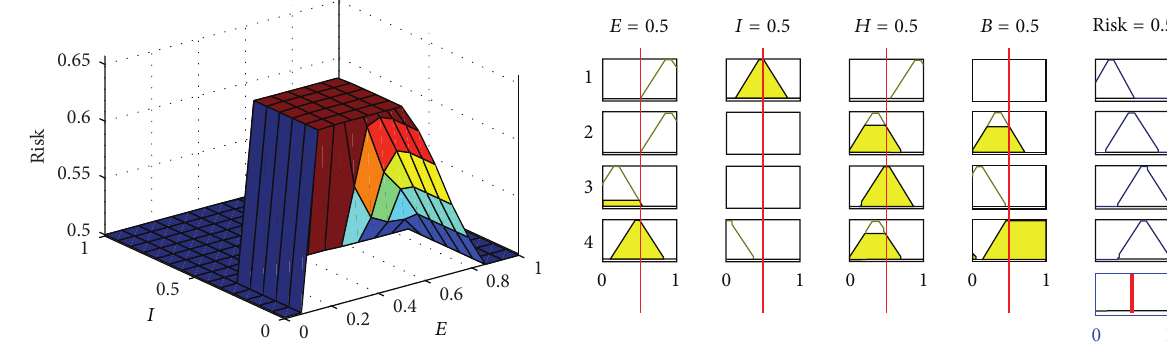
Figure 7: The results from prediction of scheduled risk of the first project with Mamdani-type fuzzy